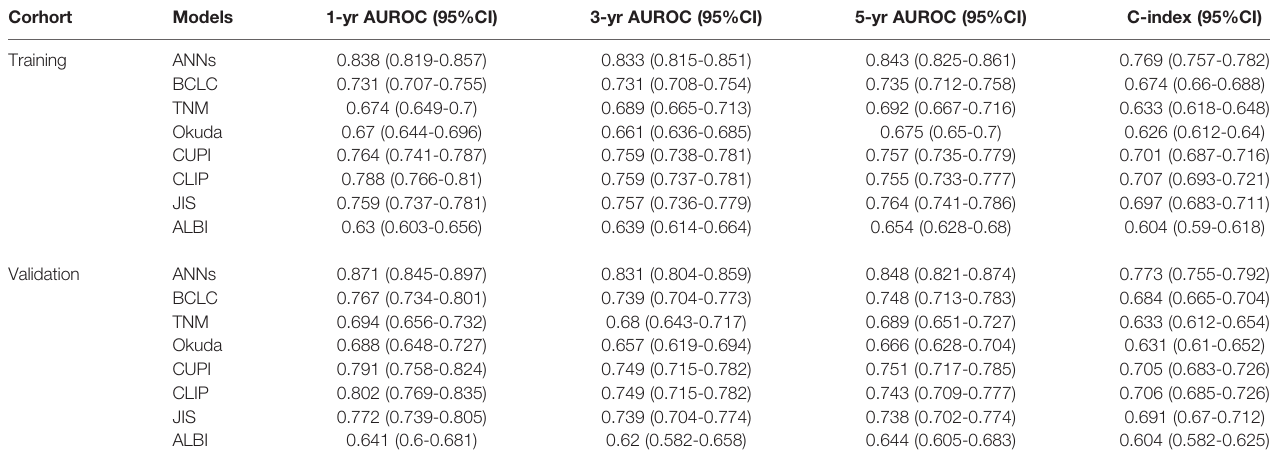
TABLE 4 | Comparison of the performance and discriminative ability between the ANNs model and conventional models.